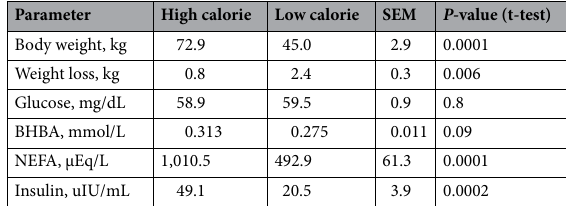
Table 3. Fasting measurements in the high- and low-calorie treatments.